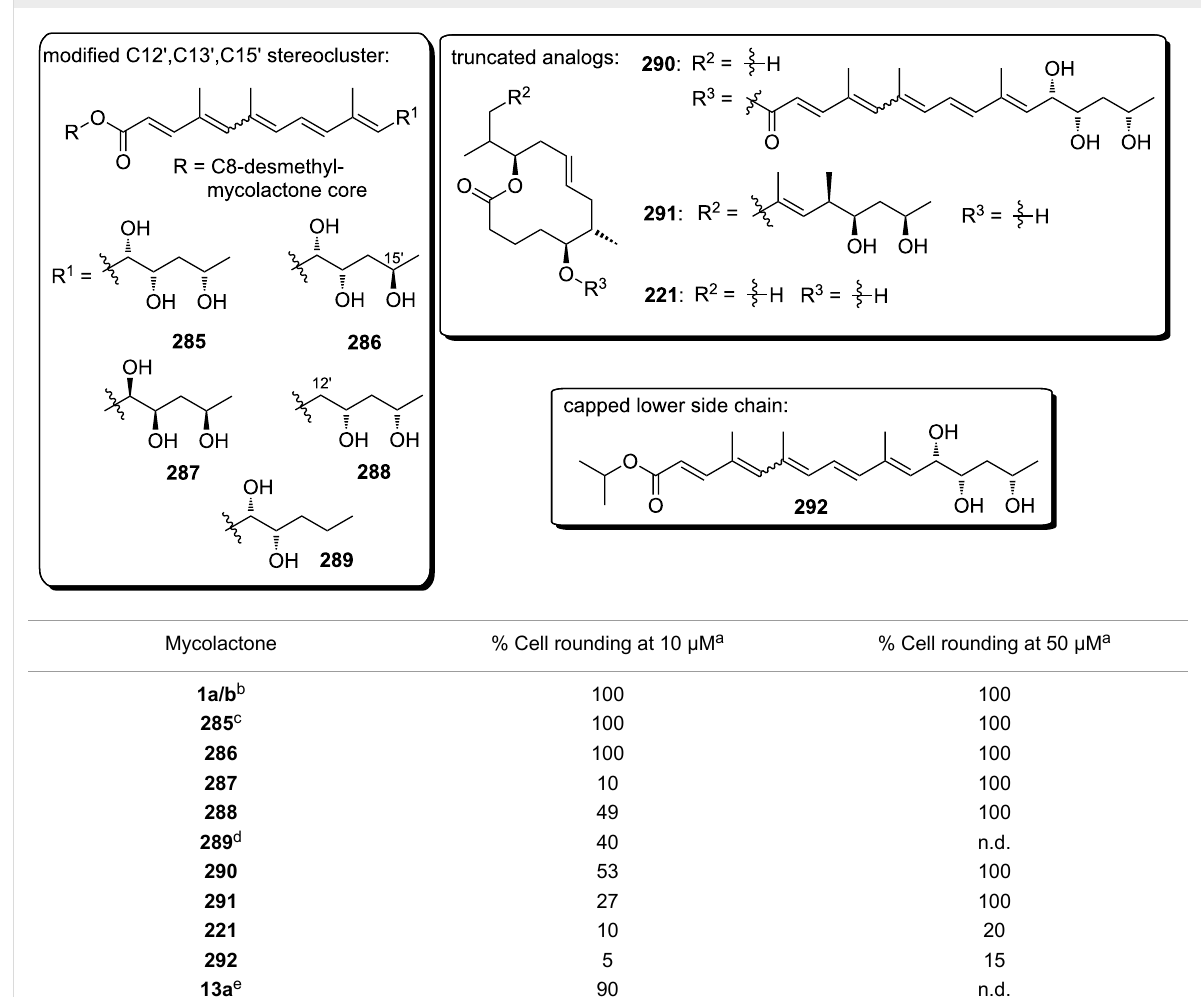
Table 3: Cytopathogenic activities of C8-desmethylmycolactone